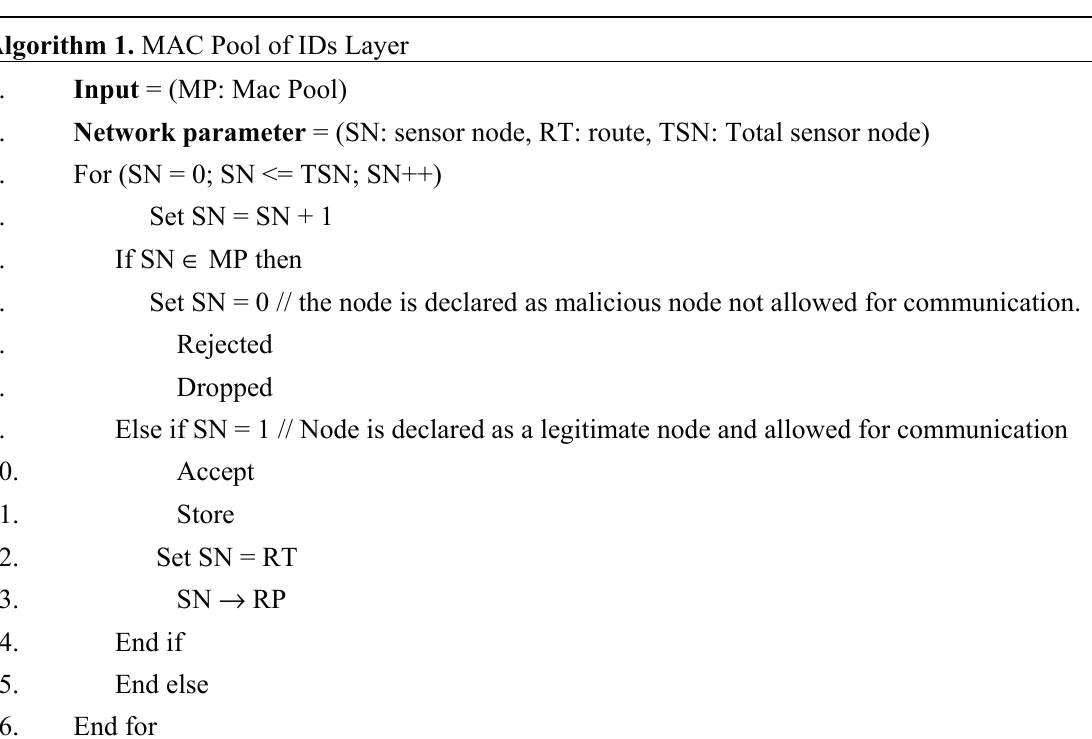
Algorithm 1. MAC Pool of IDs